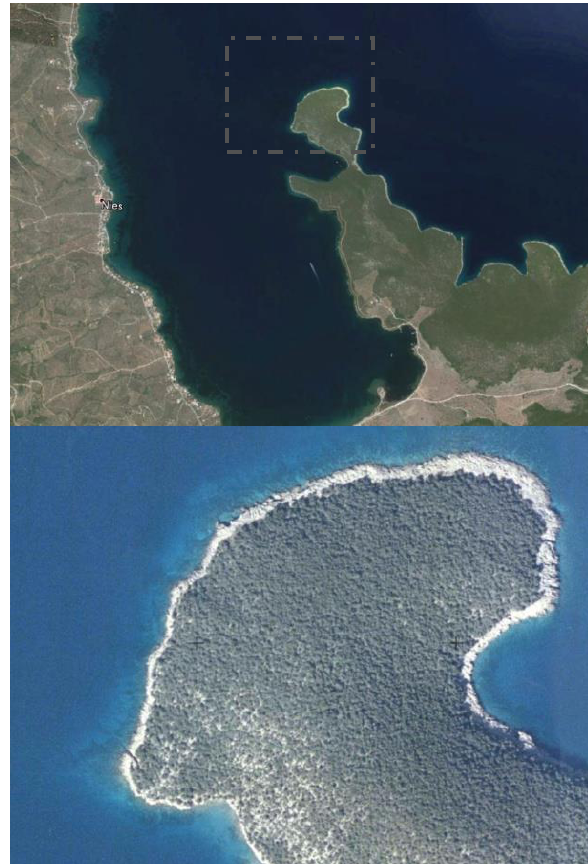
Figure 1: Cape Glaros (©Google Maps)